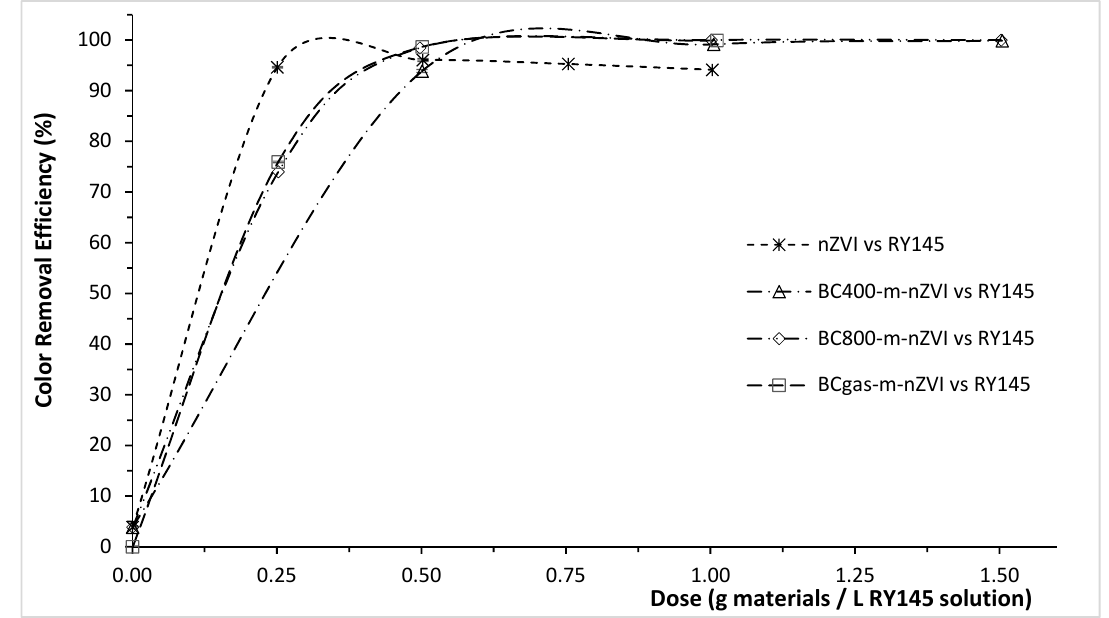
Figure 4. Color removal efficiency of the materials of nano zero valent iron (nZVI), magnetic-nZVI gasified rice husk biochar (BCgas-m-nZVI); magnetic-nZVI 400 °C—pyrolyzed rice husk biochar (BC400-m-nZVI); and magnetic-nZVI 800 °C—pyrolyzed rice husk biochar (BC800-m-nZVI) for reactive yellow dye (RY145) in dyeing solution.